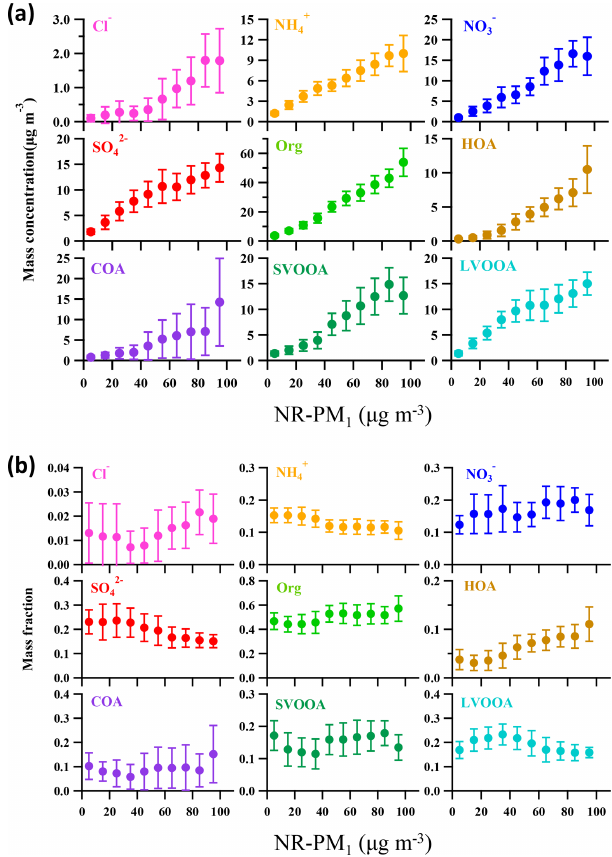
Figure 7. Dependences of (a) mass concentration and (b) mass frac- tion of NR-PM 1 components on NR-PM 1 mass loading. The data are plotted in an interval of 10µgm − 3 of NR-PM 1 . The error bars are standard deviations of each NR-PM 1